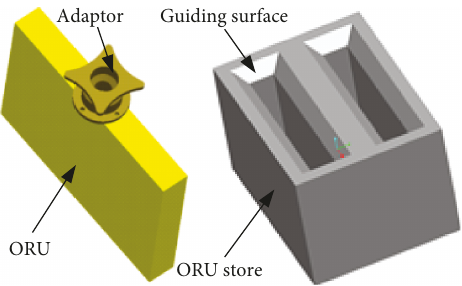
Figure 9: Simulated ORU and ORU